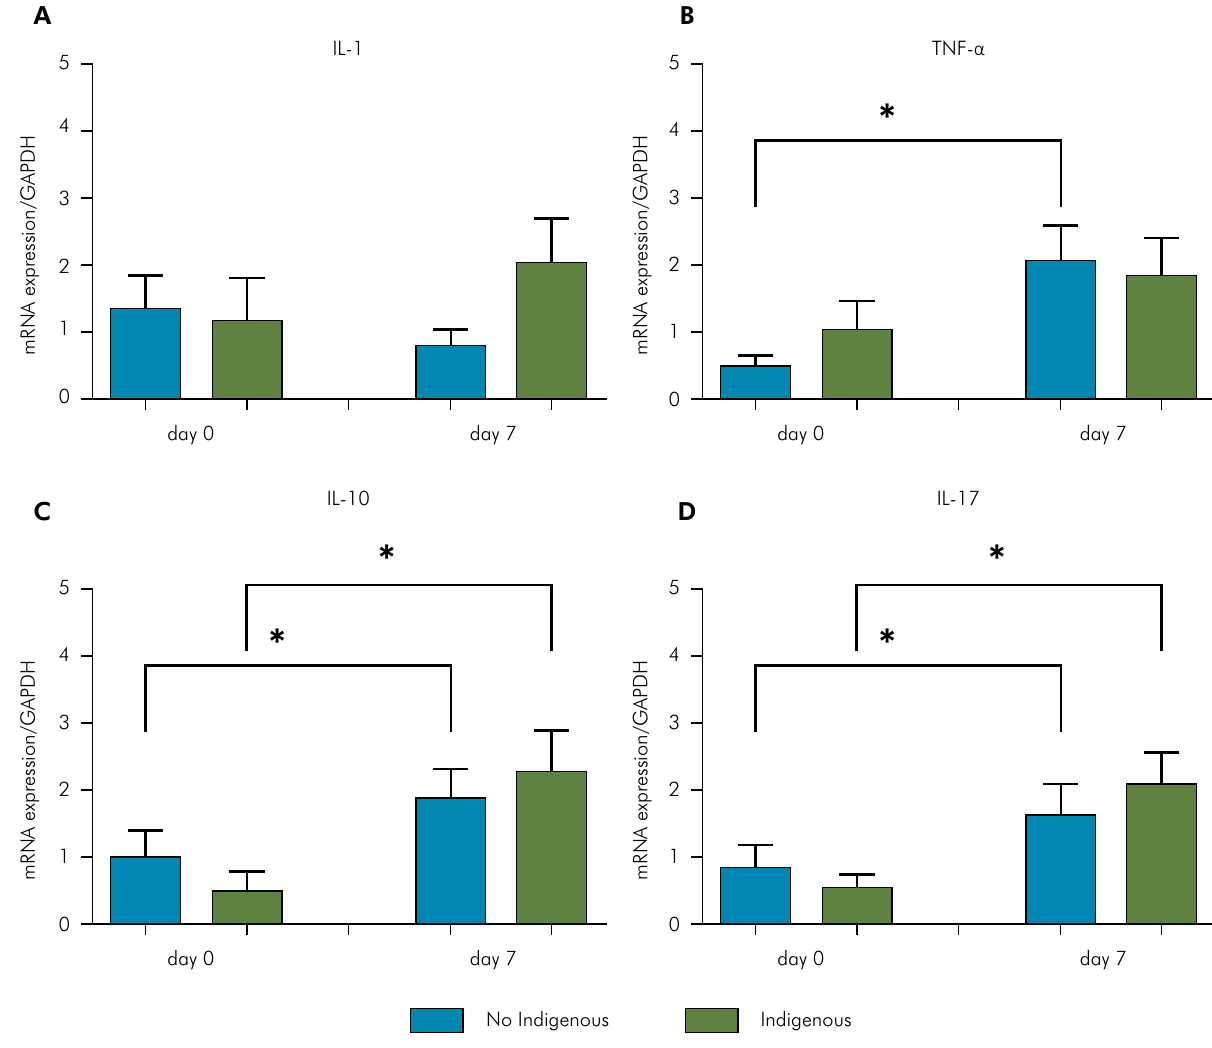
Figure 1 (a-d). Expression of TNF- α , IL-1, IL-17 and IL-10 genes in the periradicular tissues of indigenous and urban individuals with root canal infections. Levels of expression were determined by real-time PCR and quantified by comparison with an internal control (GAPDH). Bars represent the mean values of samples recovered from teeth that did or did not receive endodontic treatment; lines represent the standard error of the mean. *p < 0.05 by Wilcoxon or Mann–Whitney